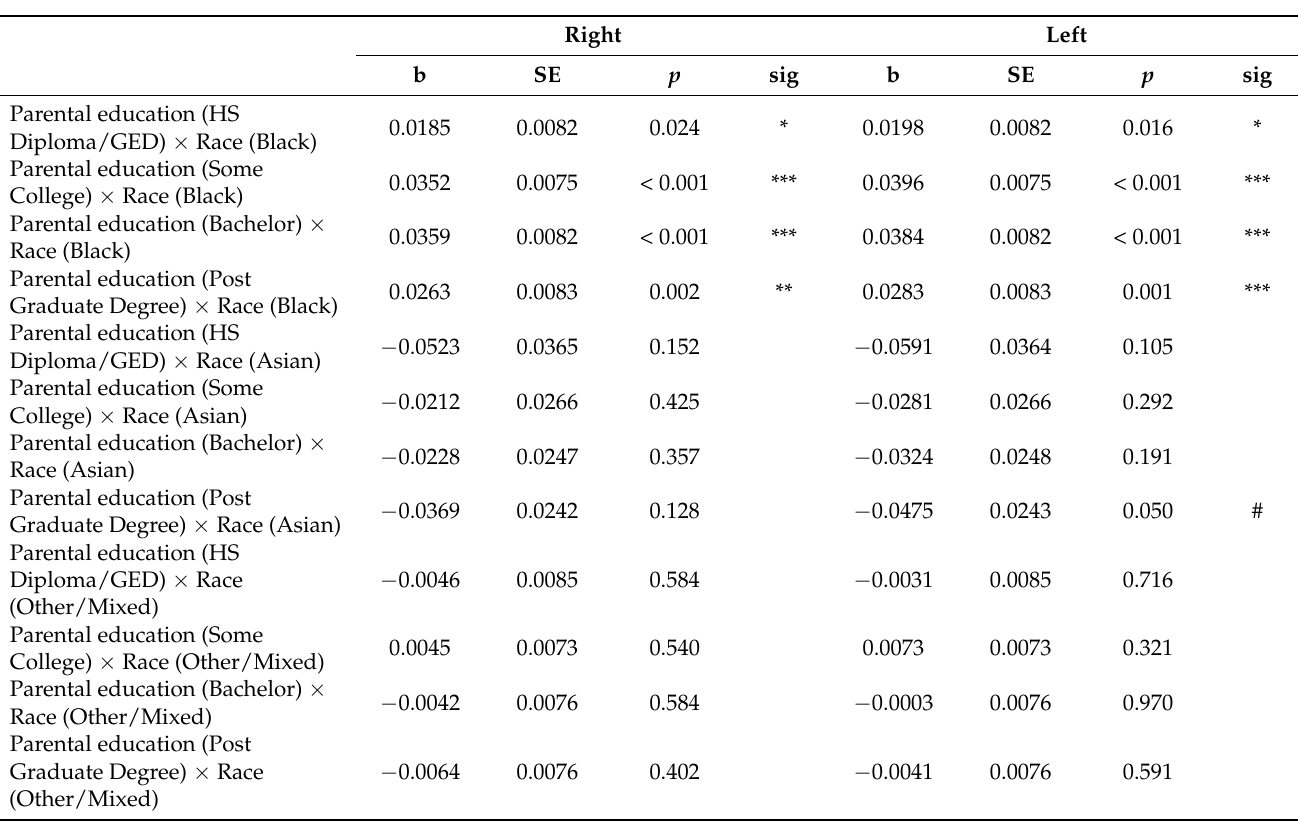
Table 4. Cont. Right